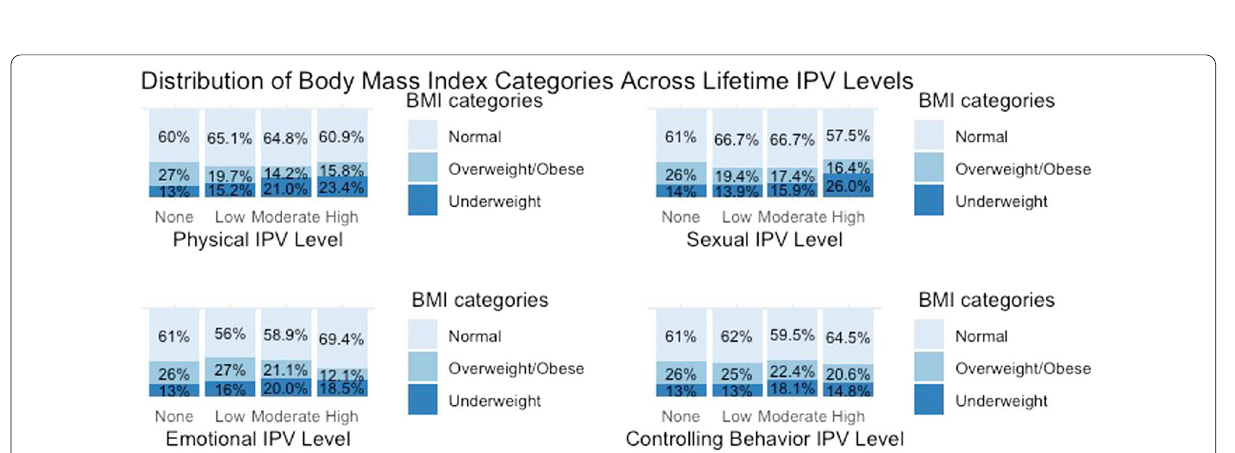
Fig. 2 Distribution of BMI categories across lifetime IPV intensity